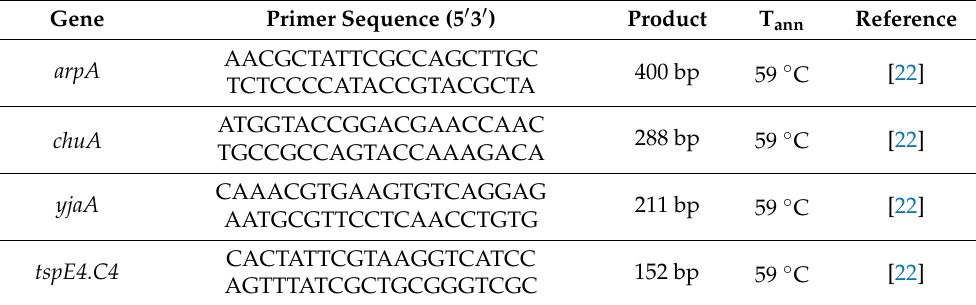
Table 1. PCR primers, length of the amplified products, annealing and references.